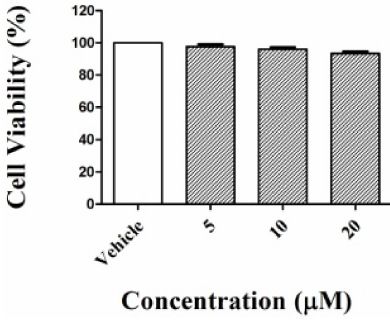
Figure 1. Viability of cells treated with acankoreagenin by the MTT assay. RIN-m5F cells were treated with various concentrations of acankoreagenin and the cytotoxicity level was determined by the MTT assay. Bars indicate SEM ( n =